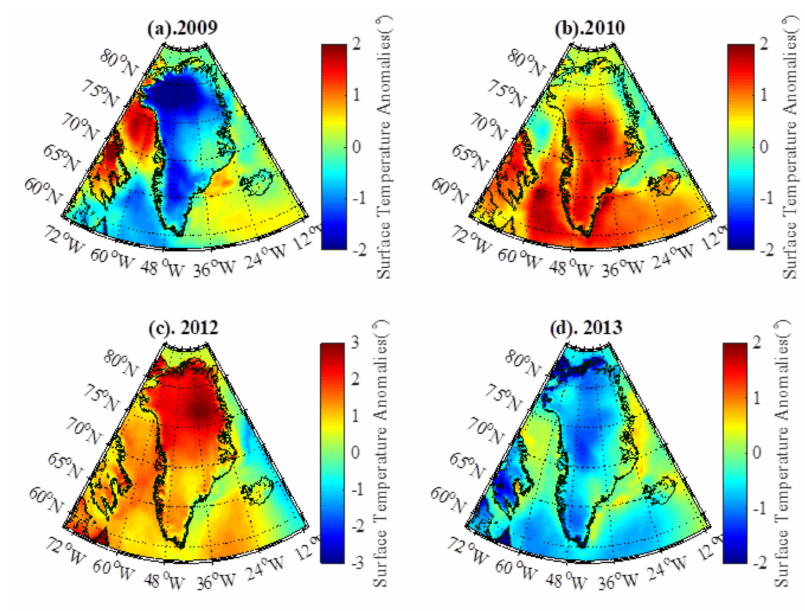
Figure 12. Summer near-surface temperature anomalies (relative to the average over 2000–2016) in: ( a ) 2009, ( b ) 2010, ( c ) 2012, and ( d ) 2013.